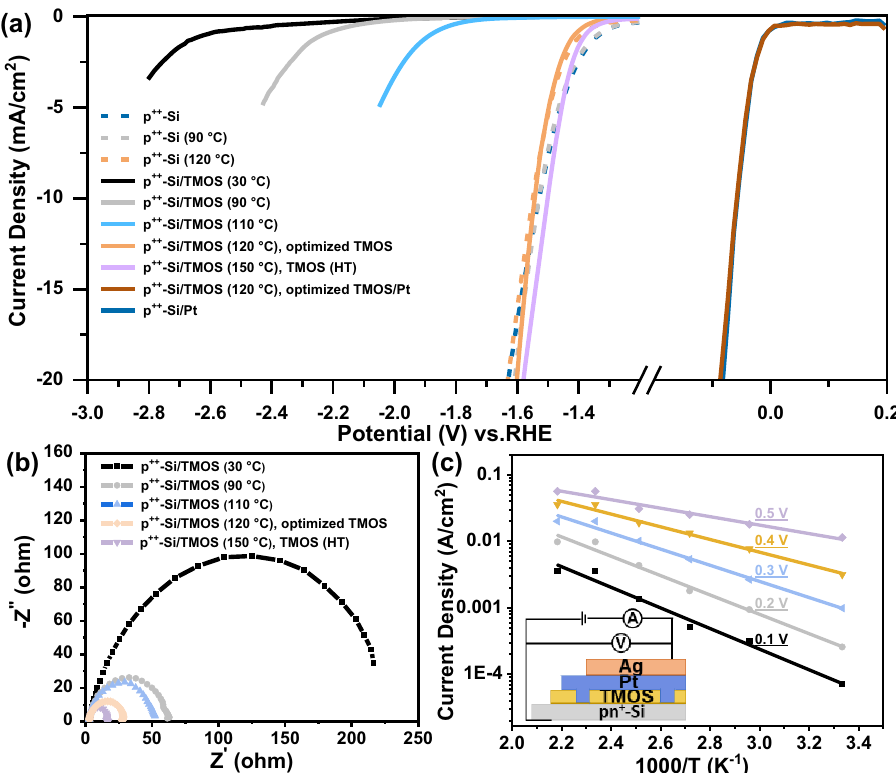
Fig. 2 | Impacts of TMOS baking temperature on electron transfer ef fi ciency. a J – V curves of planar p ++ -Si with different treatments. b Nyquist plots of planar p ++ -Si/TMOS formed under different temperatures at − 1.4V vs. RHE. c Current-